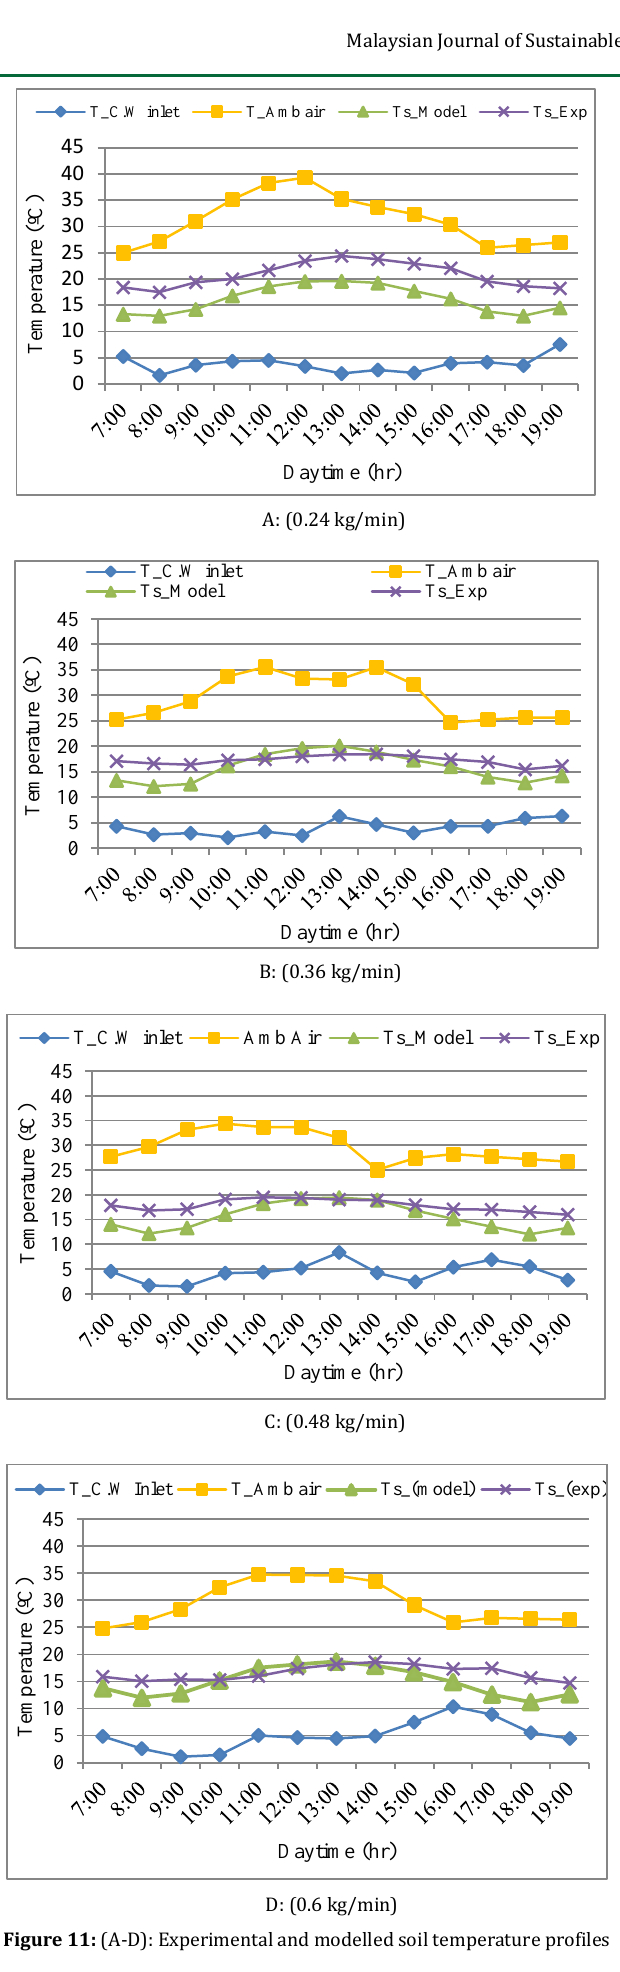
Figure 11: (A-D): Experimental and modelled soil temperature profiles